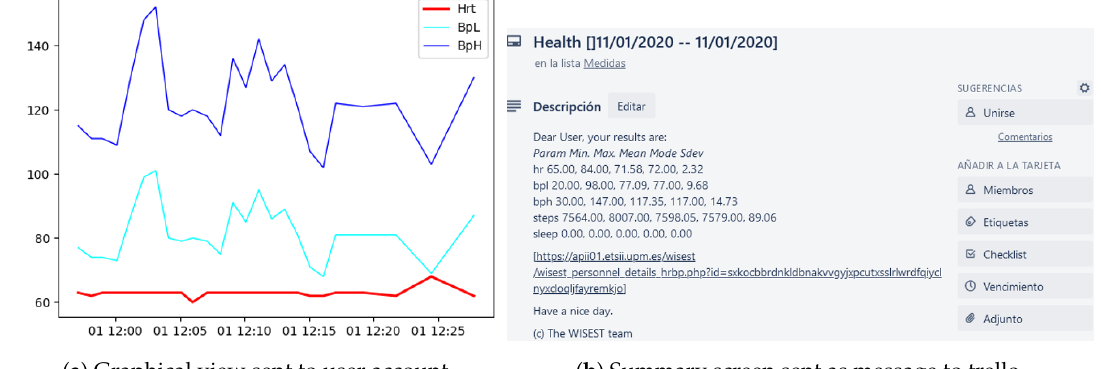
Figure 9. Informative user phone screens where time granularity can be configured.